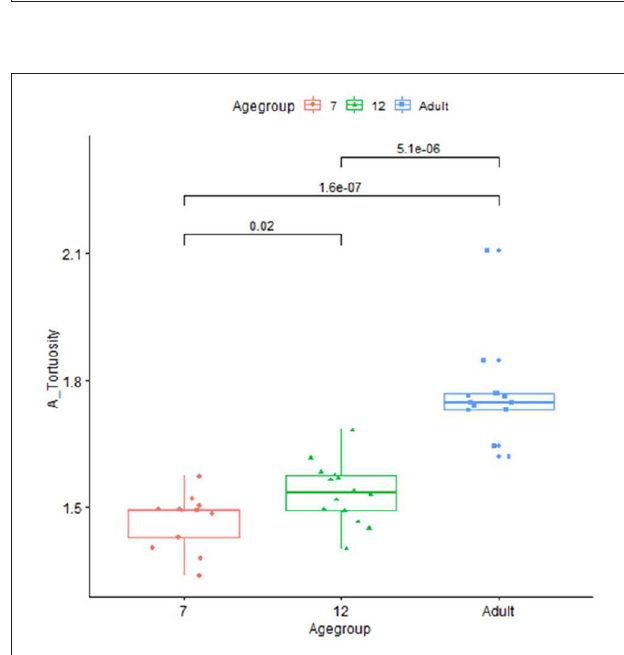
FIGURE 5 | Plot for tortuosity in infants (age group in months) and